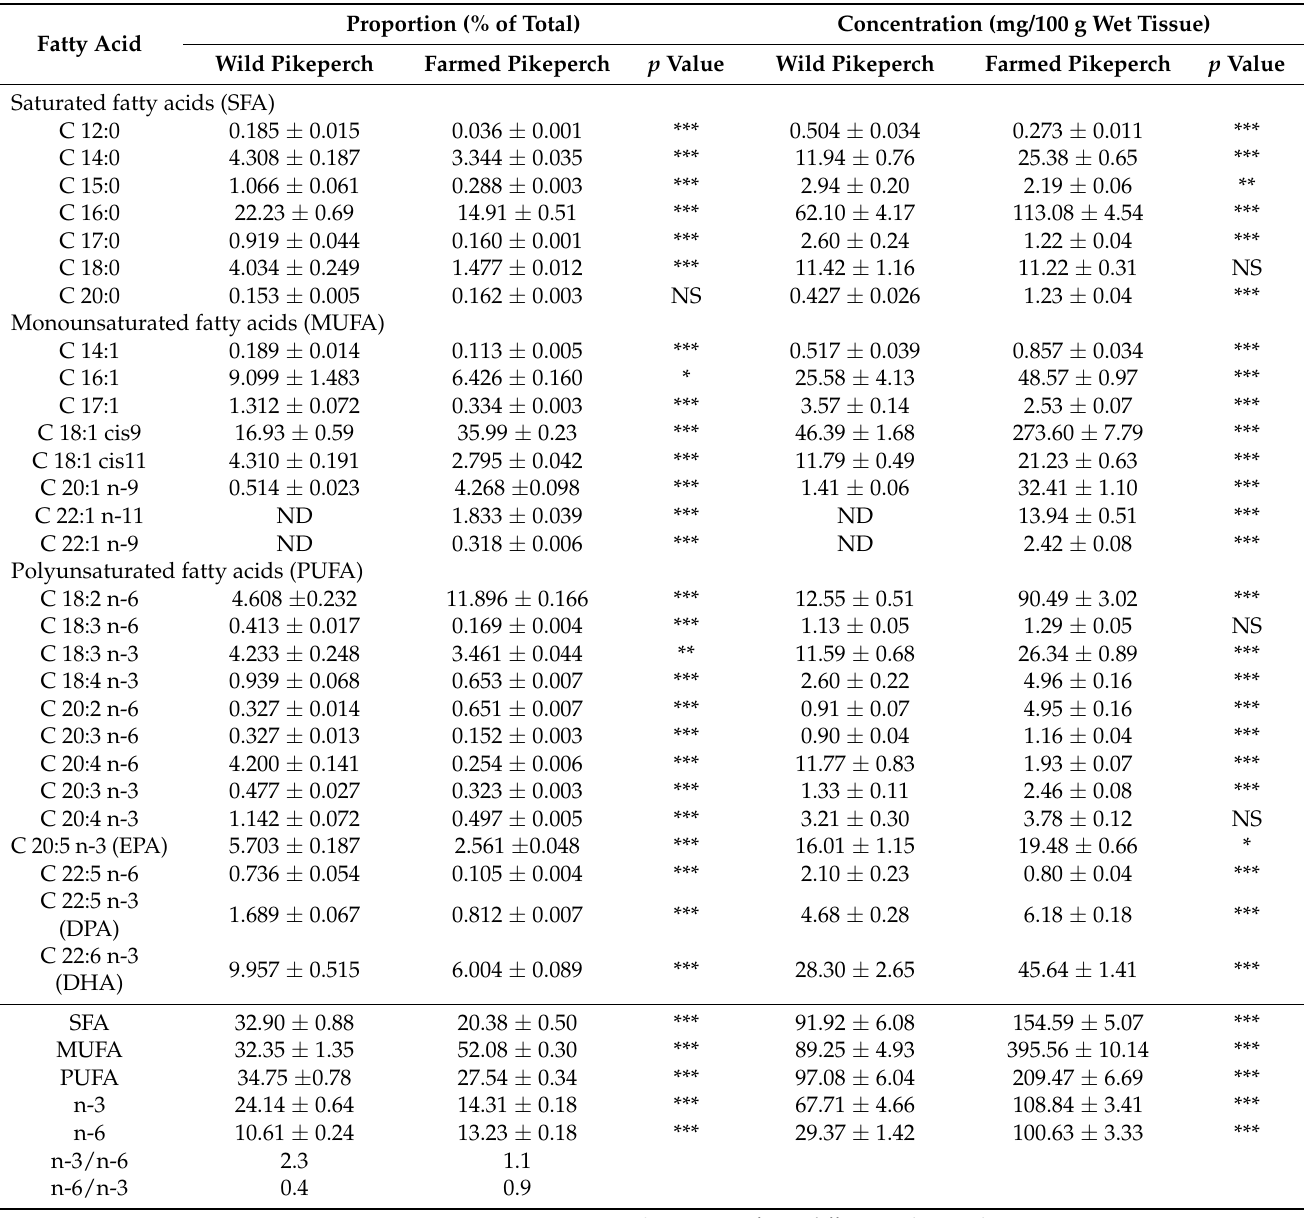
Table 4. Fatty acid composition of raw wild ( n = 12) and farmed ( n = 12) pikeperch (mean val- ues ± standard